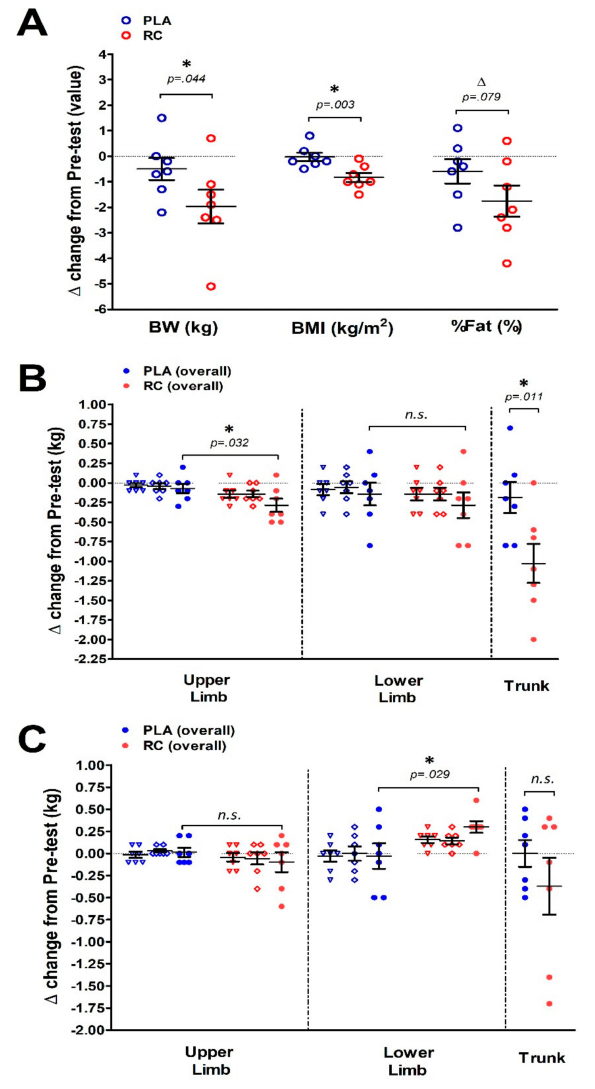
Figure 3. Changes in the body composition between the placebo and RC groups after eight weeks of intervention. The RC group showed lower body weight, BMI ( A ) and upper limb adipose tissue ( B ) after intervention. Compared to the placebo group, the RC group showed higher muscle mass in the lower limb ( C ) after treatment. BW: Body weight; BMI: Body mass index; % BF: Percentage of fat mass. Open blue circle: PLA group; Open red circle: RC group (Figure 3A). Blue open triangle / diamond: Left / right arm and leg in PLA; Blue solid circle: Upper limb / Lower limb (sum of left + right arm / leg in PLA). Red open triangle / diamond: Left / right arm and leg in RC; Red solid circle: Upper limb / Lower limb (sum of left + right arm / leg in RC) (Figure 3B,C). * denotes the significant difference between the placebo and RC groups ( p < 0.05). Values are expressed as the mean ±